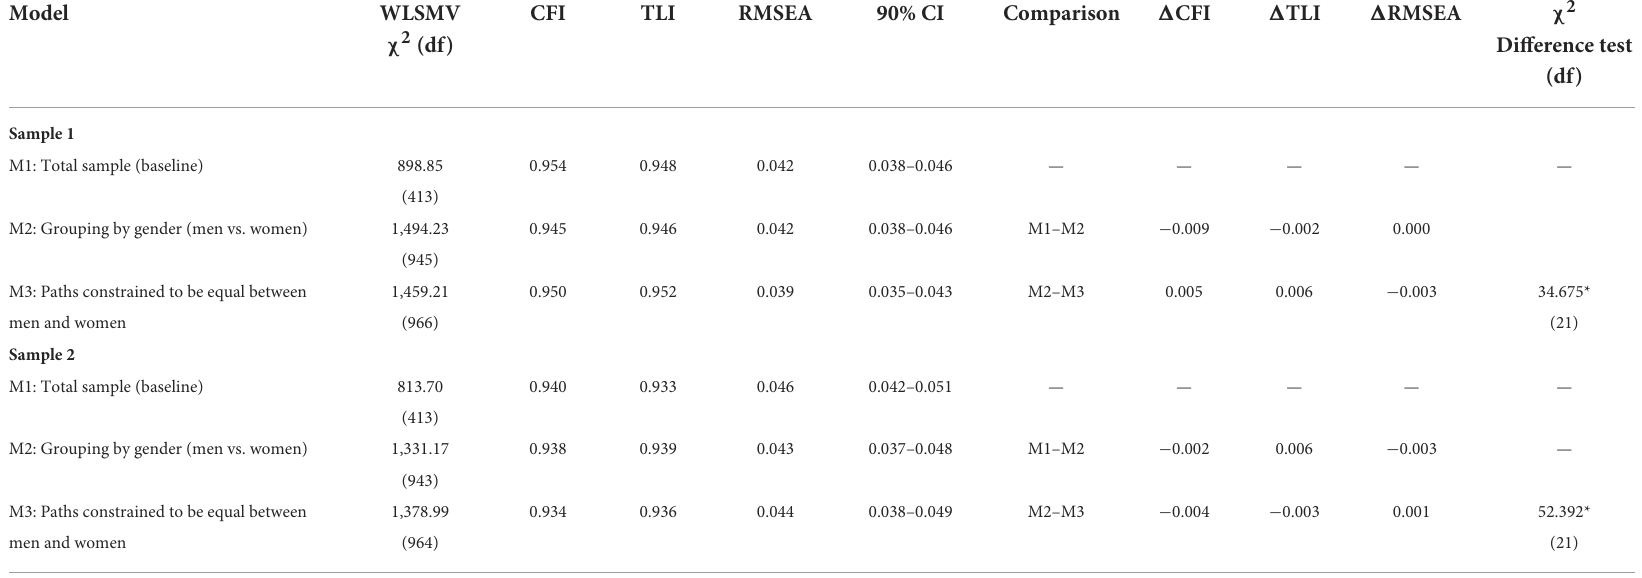
TABLE 3 Comparison of the associations between time perspectives, hypersexuality, and problematic pornography use among men and women. Model WLSMV CFI TLI RMSEA 90% CI Comparison 1 CFI 1 TLI 1 RMSEA χ 2 χ 2 (df)